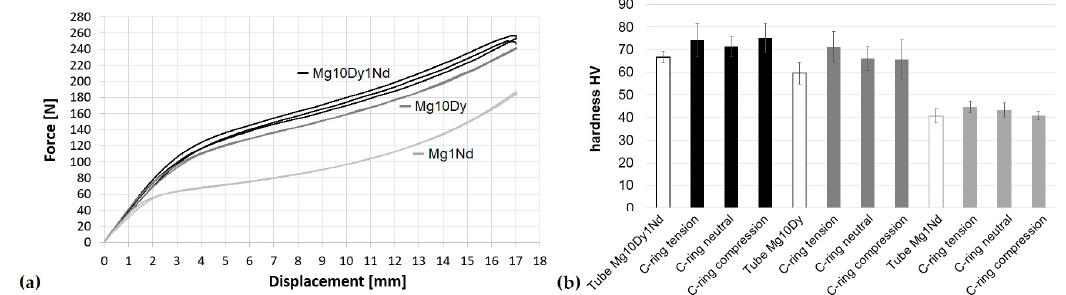
Figure 4. Force-displacement curves of C-ring tests of the Mg10Dy1Nd, Mg10Dy and Mg1Nd alloys ( a ) and hardness before and after C-ring tests up to a displacement of 7 mm ( b ).